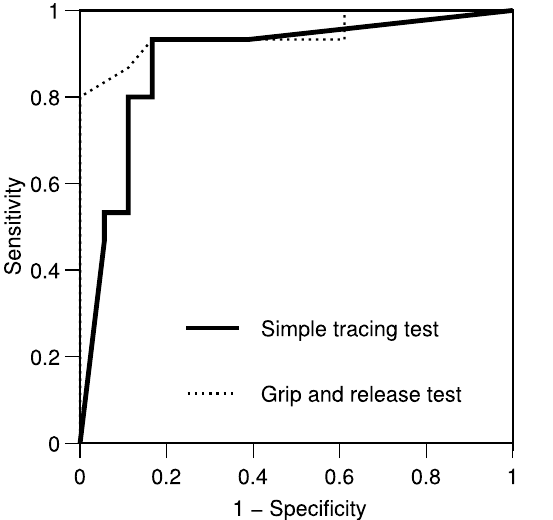
Figure 1. ROC curves for simple tracing test (STT) and GRT. The solid line shows STT and the dotted line shows GRT.